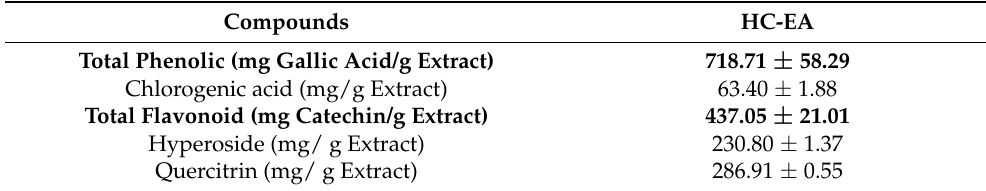
Table 1. Determination of total phenolic contents, total flavonoid contents, and phytochemical compounds in HC-EA. Data are representative of three independent experiments as mean ±